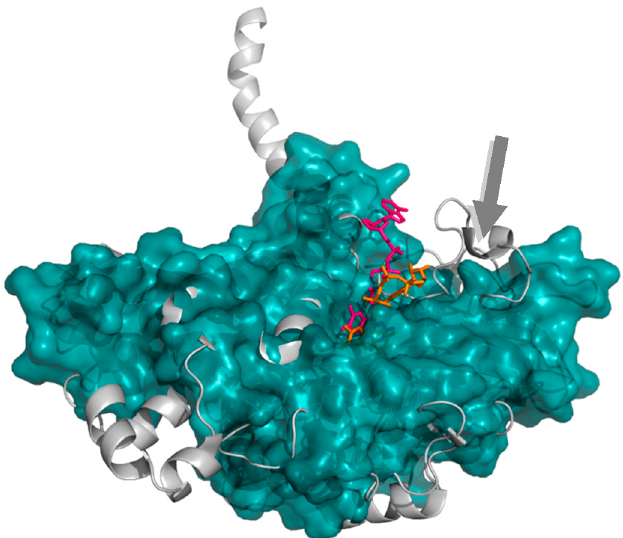
Figure 5. Structural comparison of the monomers of 4-hydroxyphenylacetate 3-hydroxylase (PDB ID: 2YYJ) and XiaF (PDB ID: 5MR6). HPAH is shaded in grey with bound FAD (purple). XiaF is displayed including surface (deep teal) with bound FAD (orange). The loop region and therefore the substrate- binding pocket (indicated by an arrow) is more open in XiaF, allowing for promiscuity towards the flavin co-substrate [48].